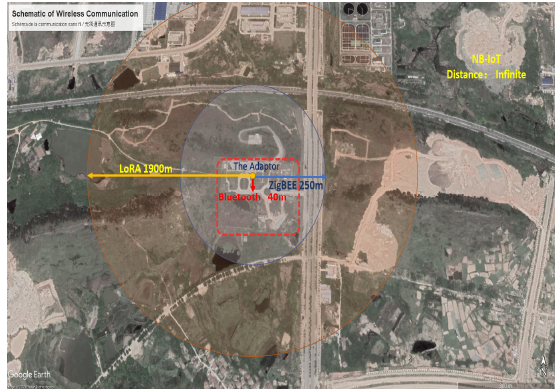
Figure 9. Schematic of Wireless